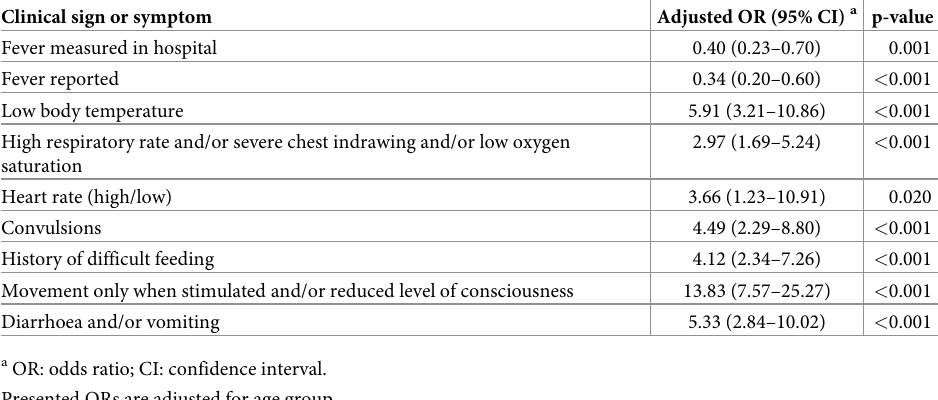
Table 8. Adjusted odds ratio for selected clinical signs and symptoms being associated with